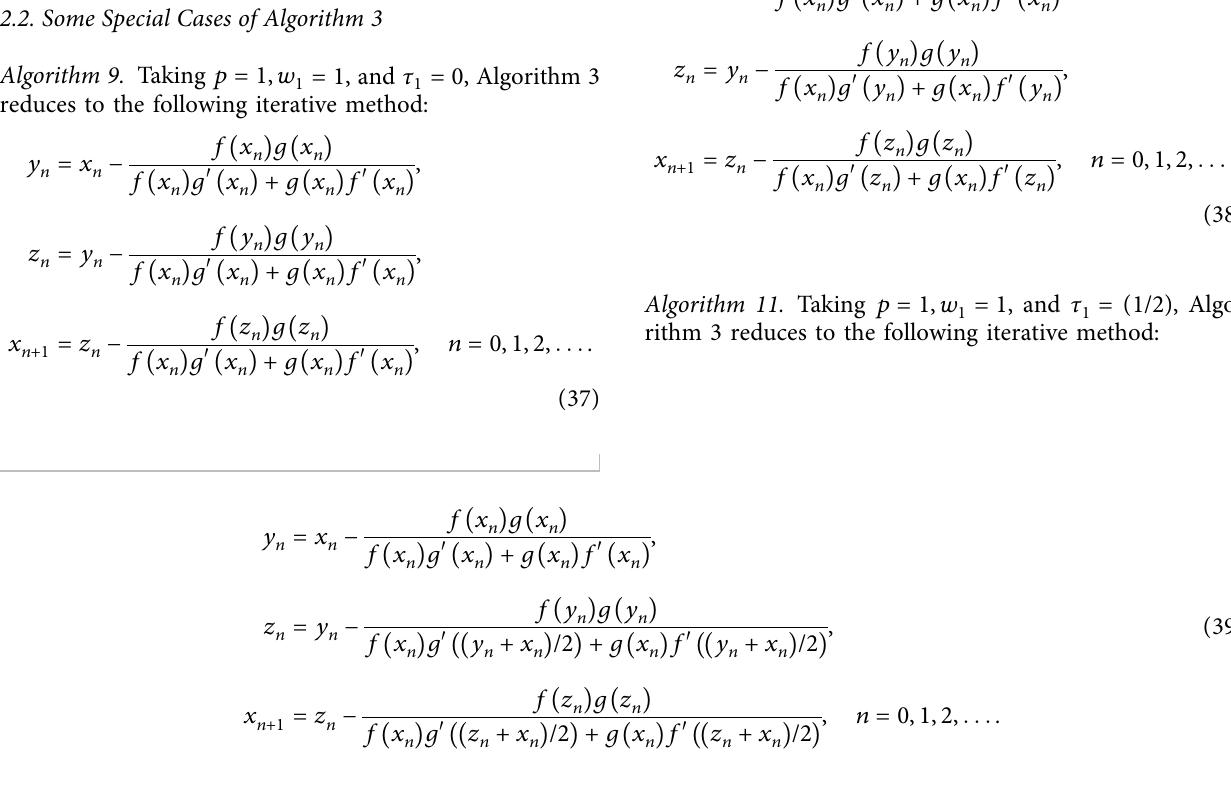
Algorithm 9. Taking p � 1 , w